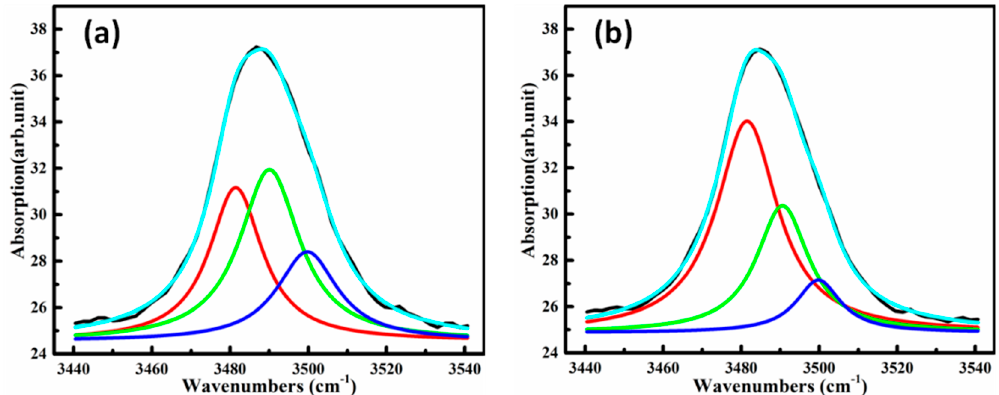
Figure 5. The components of OH − absorption spectra of LN: Mo, Hf crystals. ( a ) LN: Mo, Hf 2.0 ; ( b ) LN: Mo, Hf 3.5 .